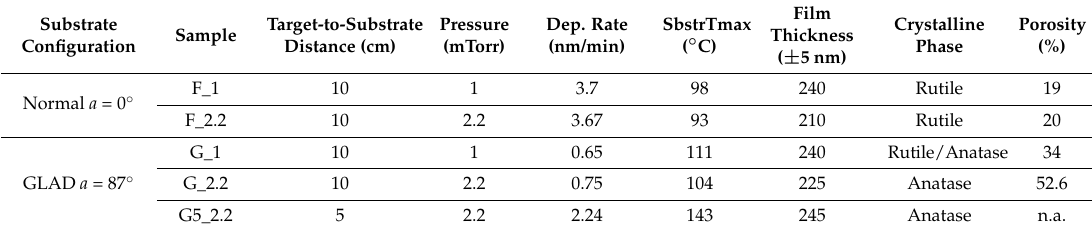
Table 1. Deposition parameters, sample nomenclature, maximum deposition temperature, film thickness, porosity, and the corresponding crystalline